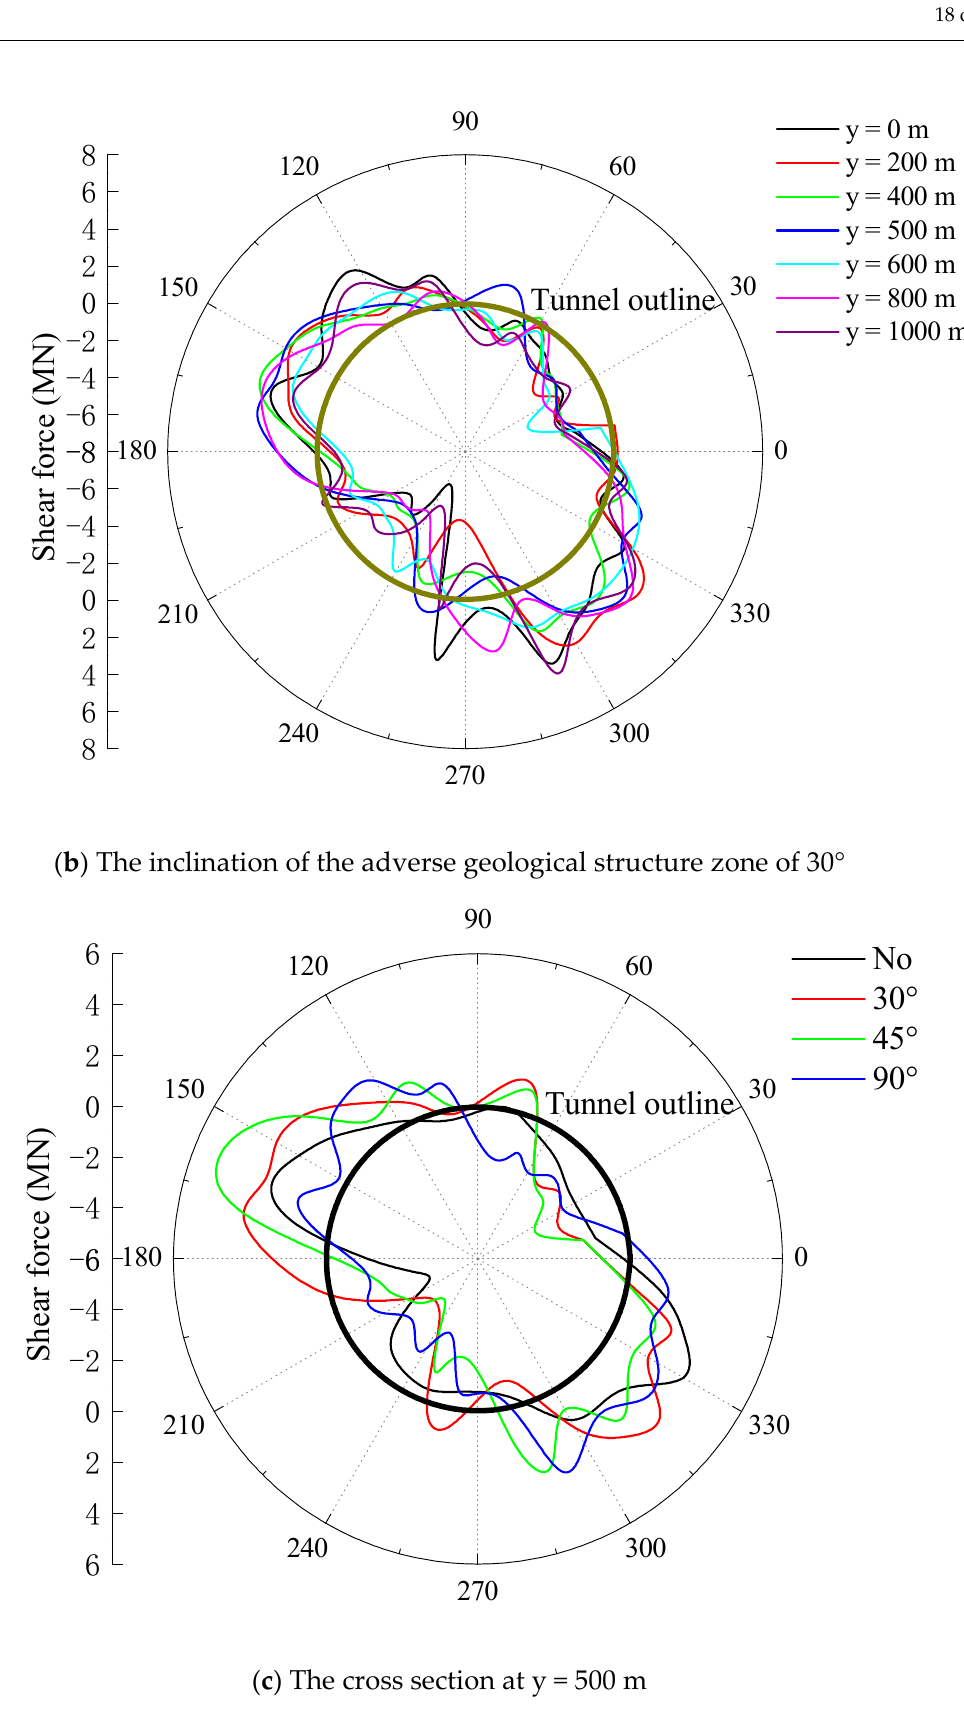
Figure 10. Shear force of lining of the tunnel passing through adverse geological structure zone with different inclinations for each cross section along the tunnel axial direction.